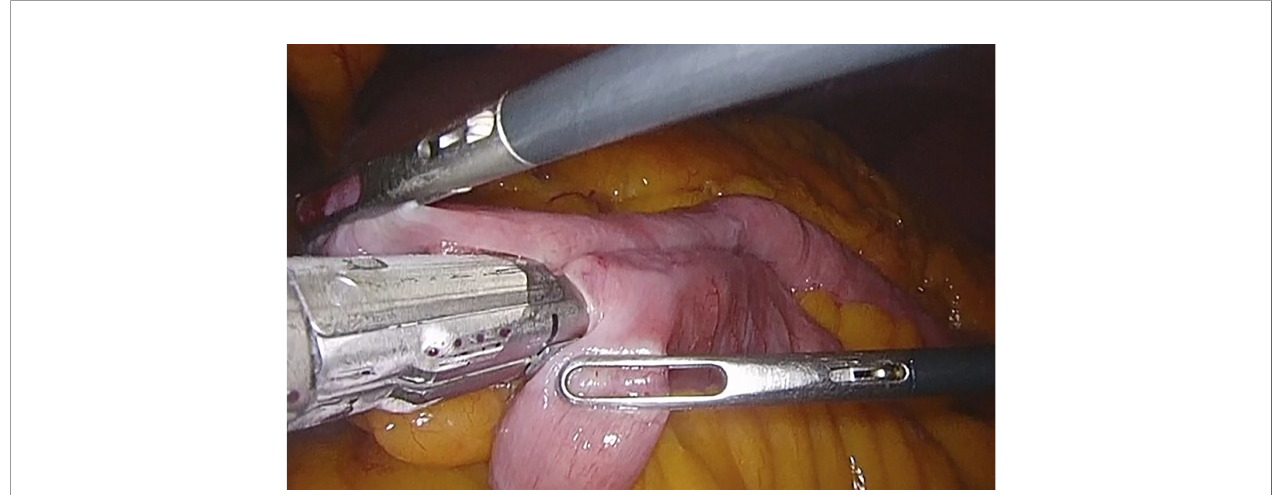
FIGURE 1 | Jejunojejunal anastomosis in the loop foot with a mechanical endostapler. Taken from the General Surgery and Digestive System Service, Hospital Royo Villanova.